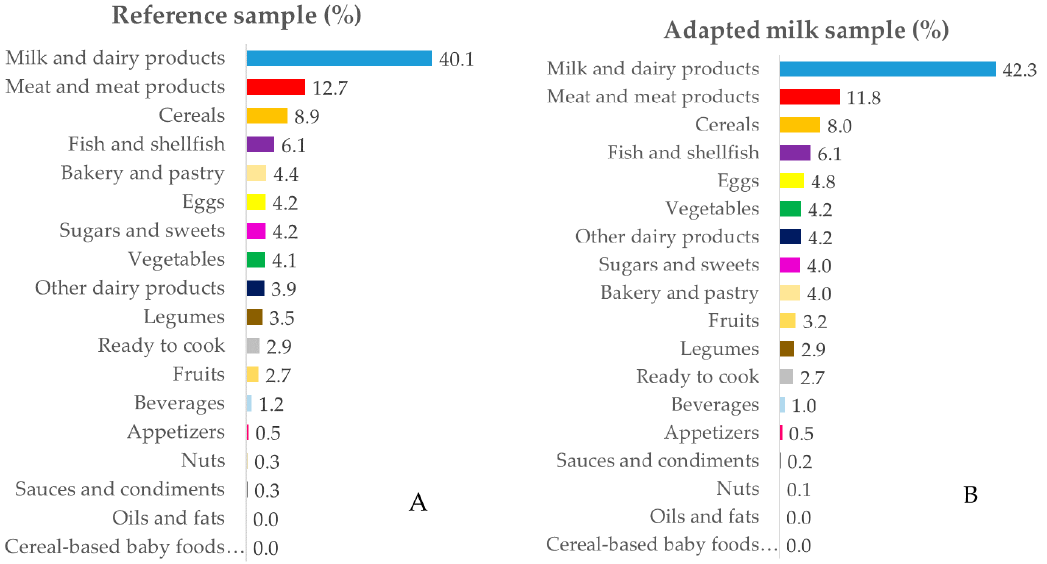
Figure 2. Percentage of the 18 food groups sources, in terms of the total phosphorus intake (%), among the reference sample ( A ) and the adapted milk consumer sample ( B ) of the Spanish Pediatric Population (EsNuPI) study.